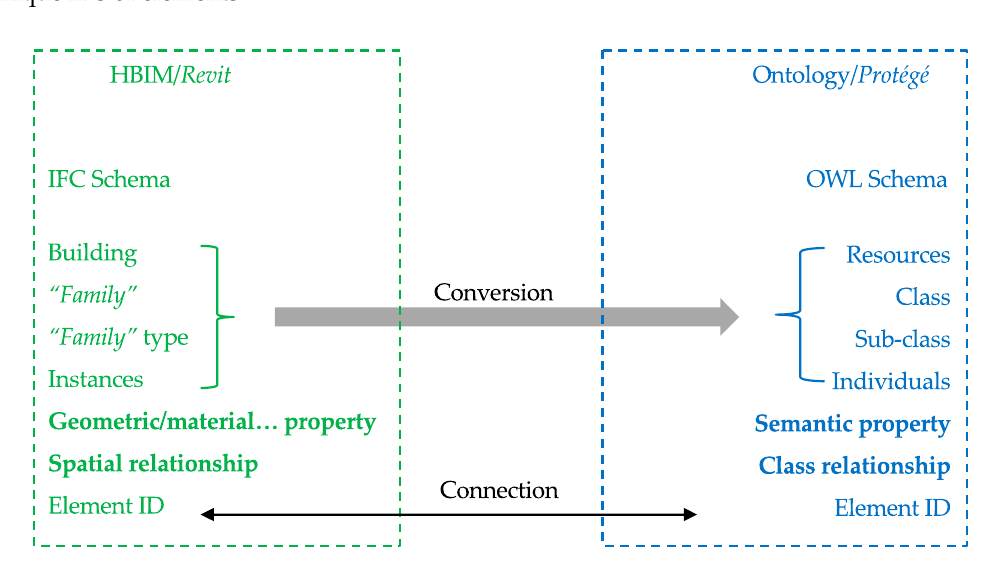
Figure 6. The correspondence between HBIM and ontology.